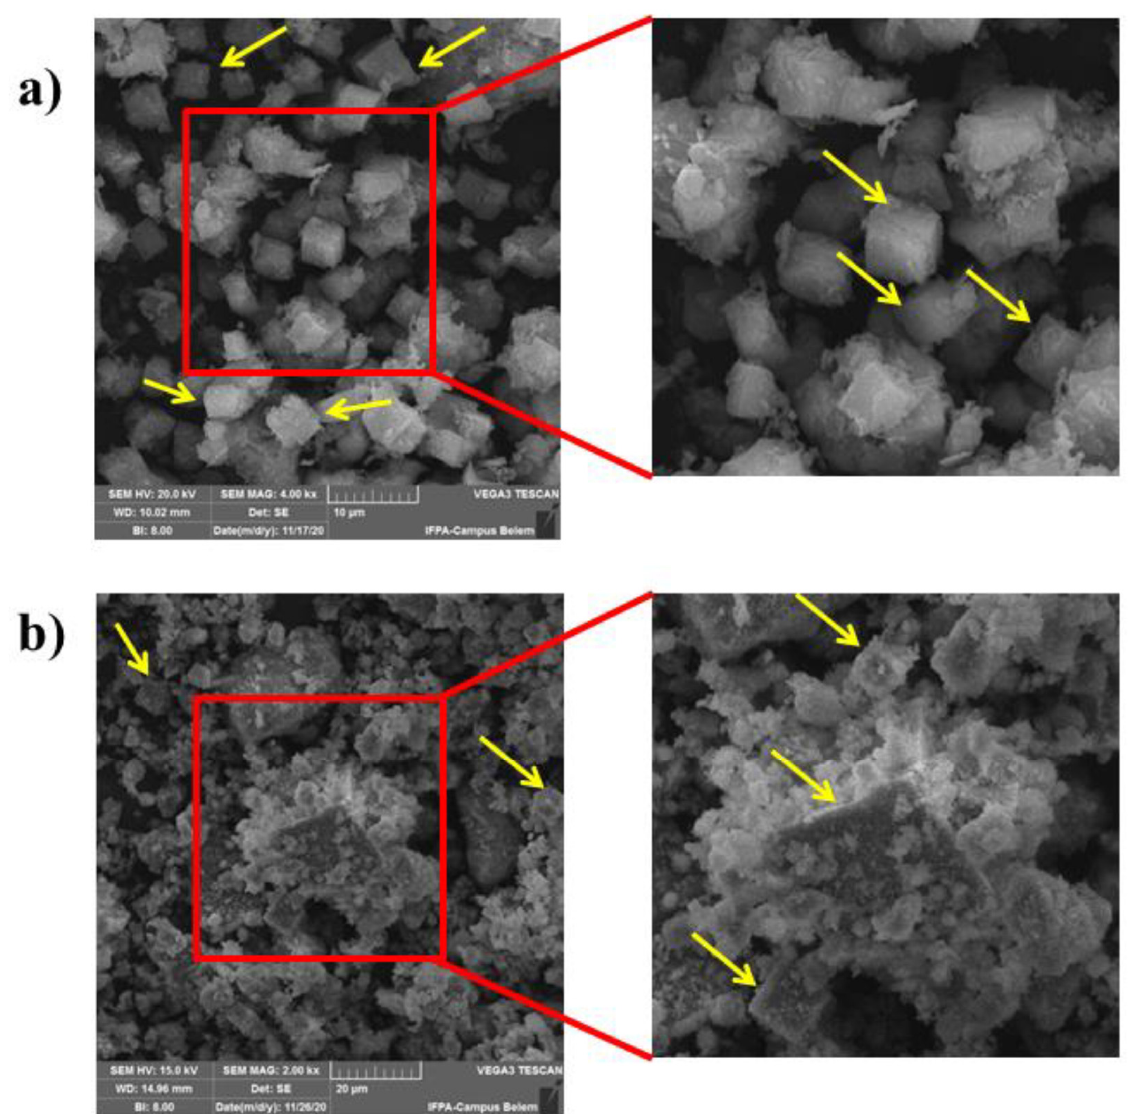
Figure 8. SEM: ( a ) processed SAPO-34-Calcined and ( b ) flint SAPO-34-Calcined.